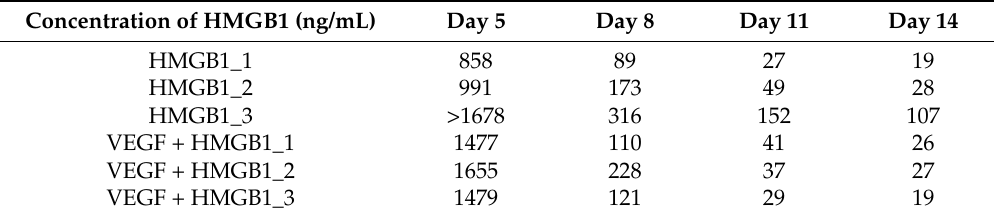
Table 2. Releasing kinetics of HMGB1. Results of HMGB1 ELISA. Concentrations of HMGB1 released by scaffolds functionalized with HMGB1 (HMGB1_1 to HMGB1_3), respectively with a combination of VEGF and HMGB1 (VEGF + HMGB1_1 to VEGF + HMGB1_3) were measured at different points in time using sandwich ELISA in (ng/mL).